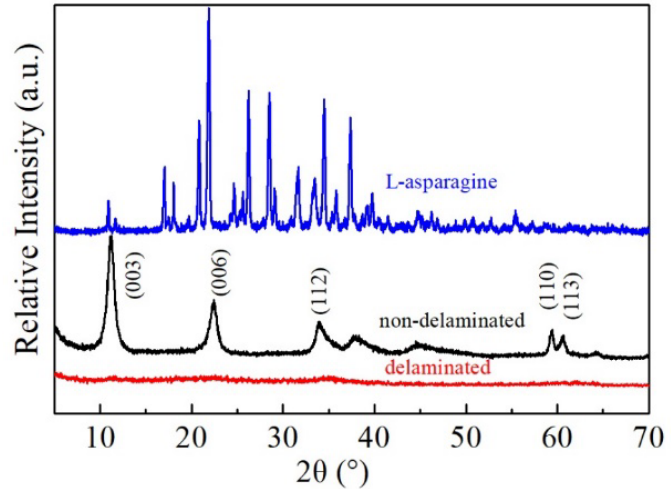
Figure 1. XRD patterns of L-asparagine, non-delaminated, and delaminated iron-based LDH.